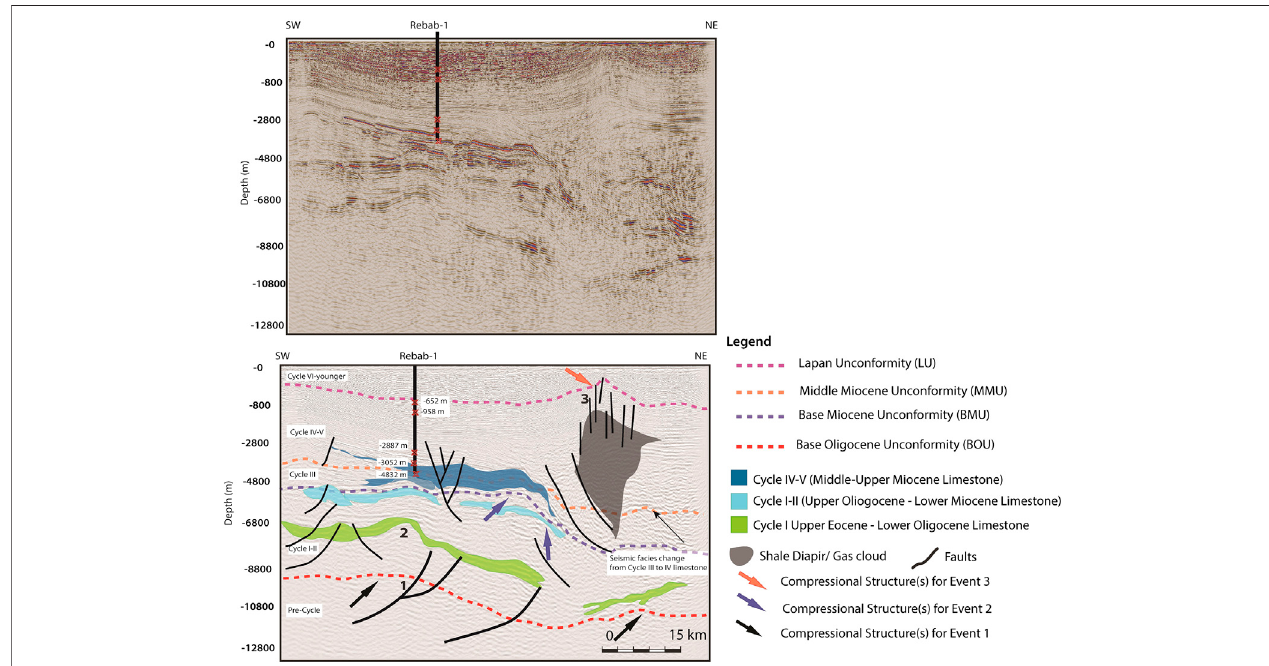
FIGURE 8 | Seismic line oriented in SW-NE, crossing Rebab-1 well. Interpretation of Middle Miocene limestone is based on the well-seismic correlation and guidanceofgeophysicalcharacteristicsofthere fl ectors.TheUpperOligoceneand UpperEocene limestone areinterpreted basedonthegeophysicalcharacters.Shale diapirisseentoseepfromEarlyMiocenesediments(SetapShale)totheyoungersedimentsthroughfaults.Locationofthelineisshownin Figure1B .Annotation1 – 3are referring to Event 1 – 3 discuss in this paper. The depths in meter (m) are representing the well to seismic tie values for the seismic markers.